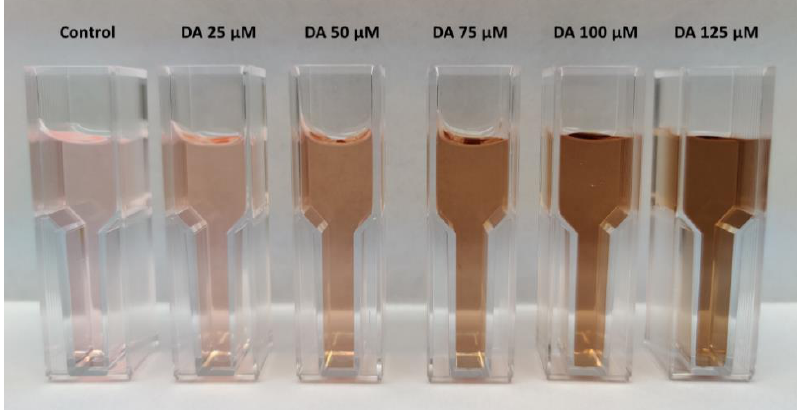
Figure 9. Shift in the color of astrocyte media with self-oxidation of DA to PDA.